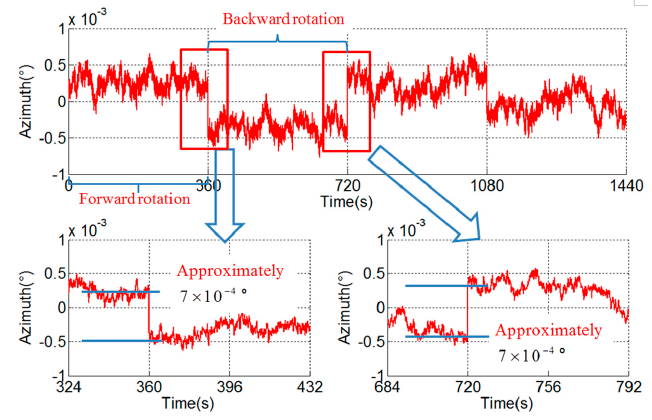
Figure 8. Stair error of azimuth ( ω = 1°/s).